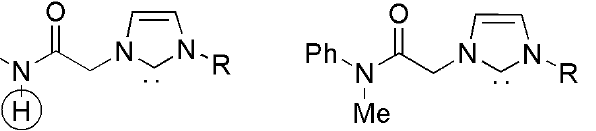
Figure 22. Side chain influence in an NHC ligand on catalytic activity of palladium complex. [191].